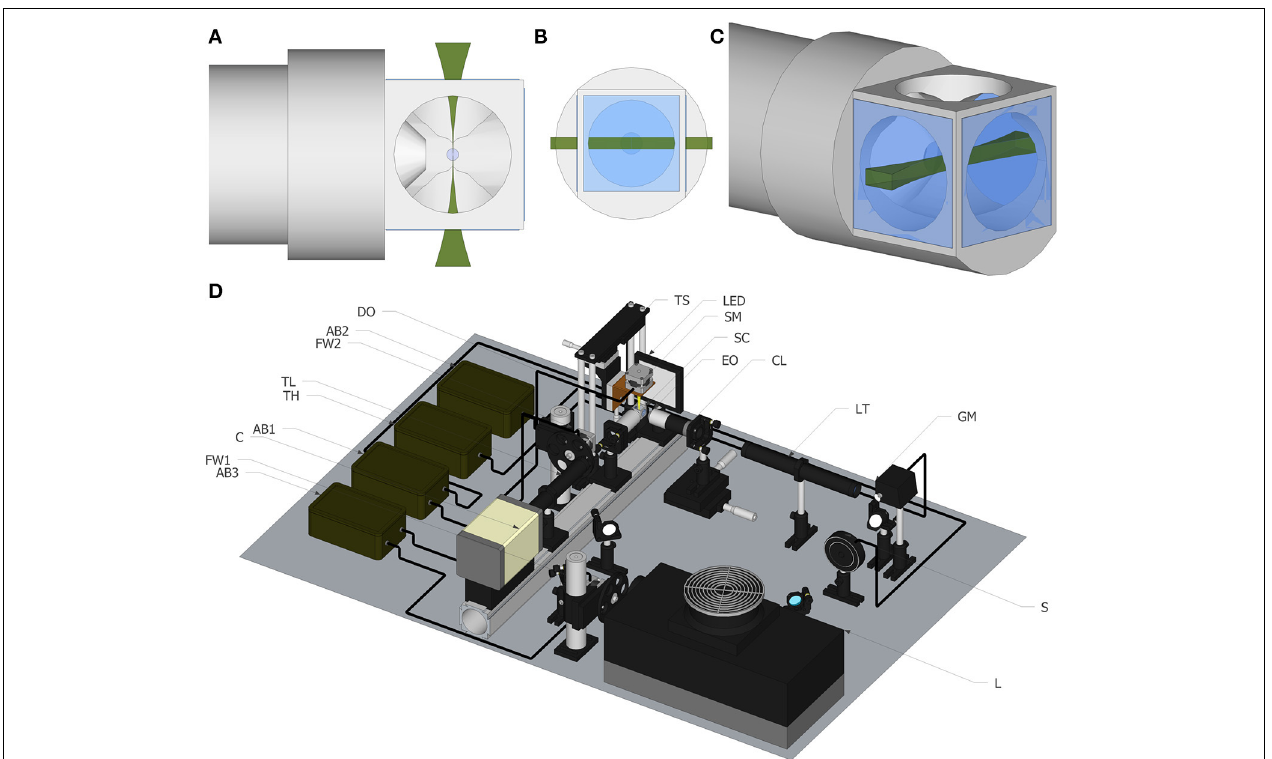
FIGURE 1 | Light sheet fluorescence microscopy. (A) Top view of the light sheet, including objective and our newly developed chamber. (B) Front view of the light sheet. (C) Perspective view of the light sheet. (D) Schematic of the experimental set up. The list of elements are: Argon/Krypton laser (L), excitation filter wheel (FW1), shutter (S)